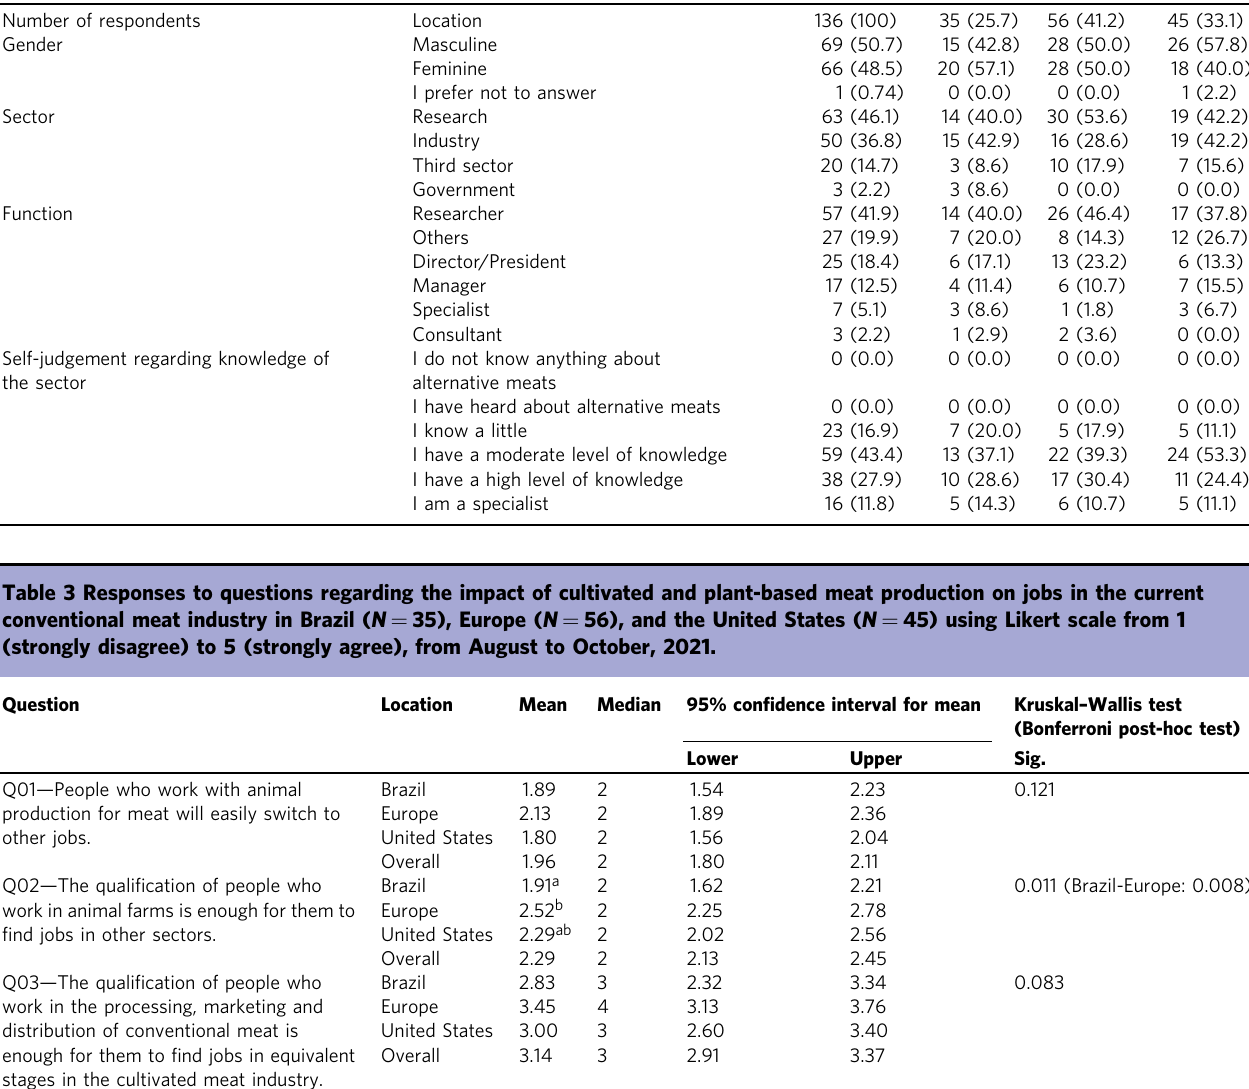
Table 2 Demographic data of the analysed sample, as per interviews from August to October 2021. Variable